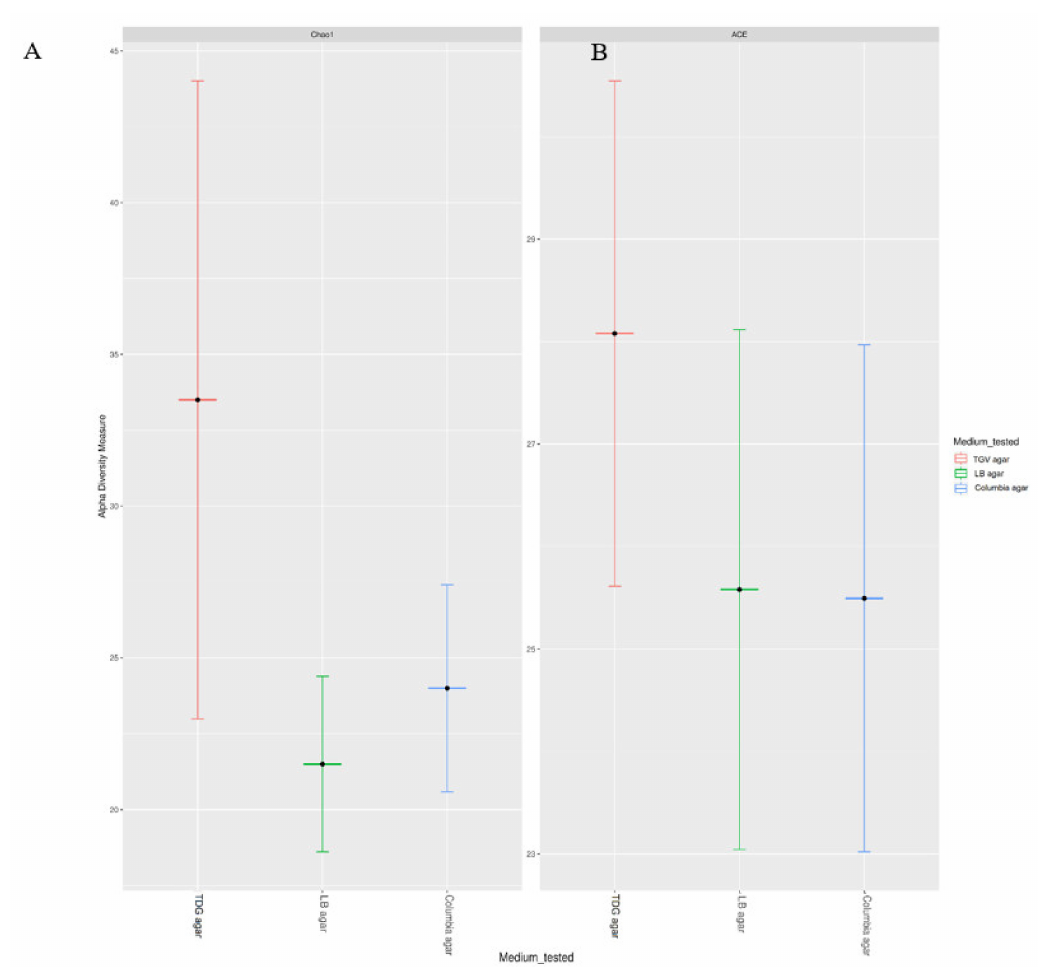
Figure 2. Increased diversity of bacterial species that showed growth on TGV medium, compared to that of species that grew on LB and Columbia agar, as revealed by the values of ( A ) Chao1 and ( B ) abundance-based coverage estimator (ACE)